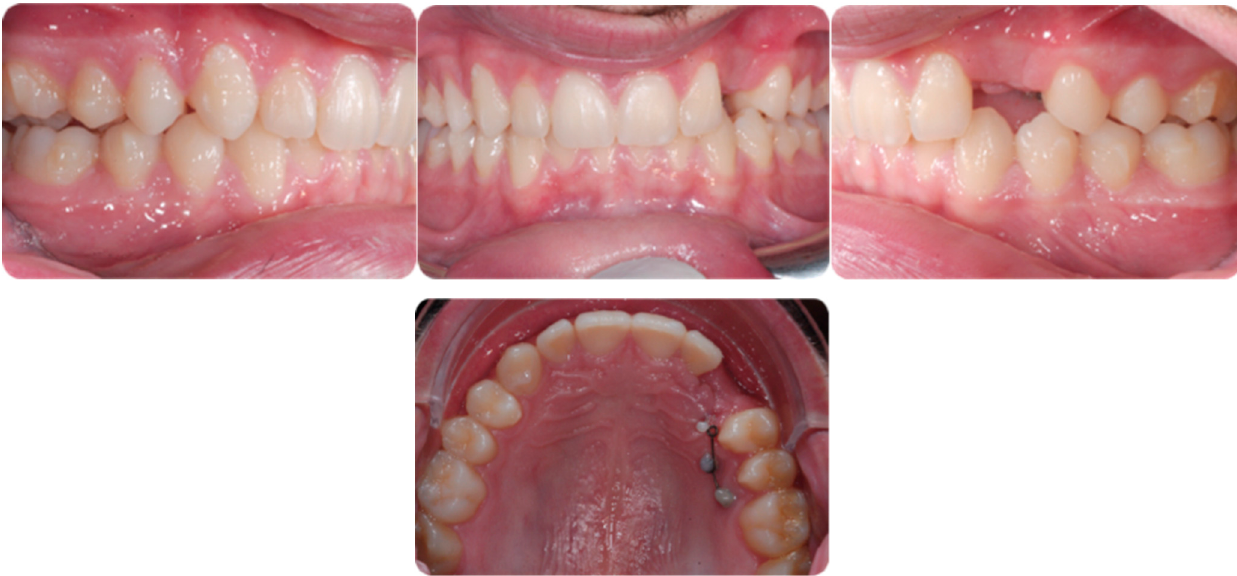
Figure 4. Initial orthodontic vertical traction on a 0-18 SS wire.